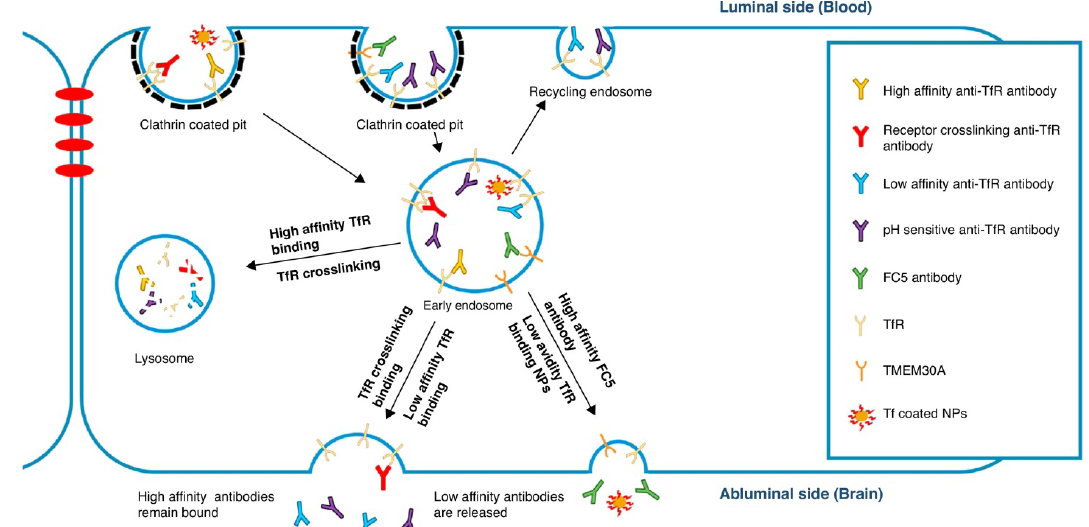
Figure 1. A schematic depiction of the various engineering optimization strategies for increased transcytosis of antibodies and nanoparticles (NPs) across the BBB. High-affinity monovalent and bivalent anti-TfR antibodies internalize readily into the early endosome (EE) but then direct the antibody–receptor complex toward lysosomal degradation, possibly by crosslinking the TfR and altering its intracellular trafficking. While high-affinity monovalent anti-TfR antibodies can transcytose the BBB, they remain bound to the receptor on the abluminal side, limiting the dose to the brain. In contrast, low-affinity anti-TfR antibodies decrease antibody-TfR sorting to the lysosome and can either be recycled back to the luminal side or are transcytosed to the abluminal side where they dissociate from TfR, leading to increased brain accumulation. Similarly, Tf-coated nanoparticles show a higher transcytosis capability when lowering the Tf coating content, resulting in reduced avidity. Further, pH-sensitive TfR-binding antibodies that can dissociate from TfR in the acidic EE lead to increased transcytosis compared with pH-insensitive antibodies. In the case of the single domain antibody FC5, increased affinity toward the receptor leads to an increase in the amount of transcytosed antibody, highlighting the fact that vectors utilizing different trafficking machinery may require customized optimization. This figure is reproduced from Goulatis and Shusta (2017) with permission of the copyright owner [7].